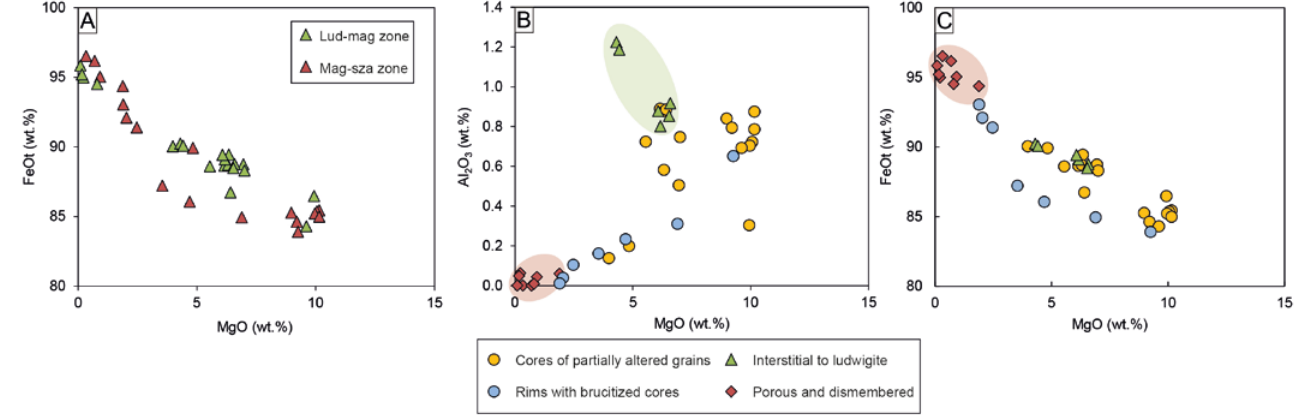
Figure 7. Binary plots showing the oxide chemical composition: ( A ) MgO vs. FeO t plot of Mg-rich magnetite and magnetite showing no differences between those located in the ludwigite–magnetite zone and the magnetite–szaibelyite zone; ( B ) MgO vs. Al 2 O 3 and ( C ) MgO vs. FeO t plots of different textured Mg-rich magnetite and magnetite.